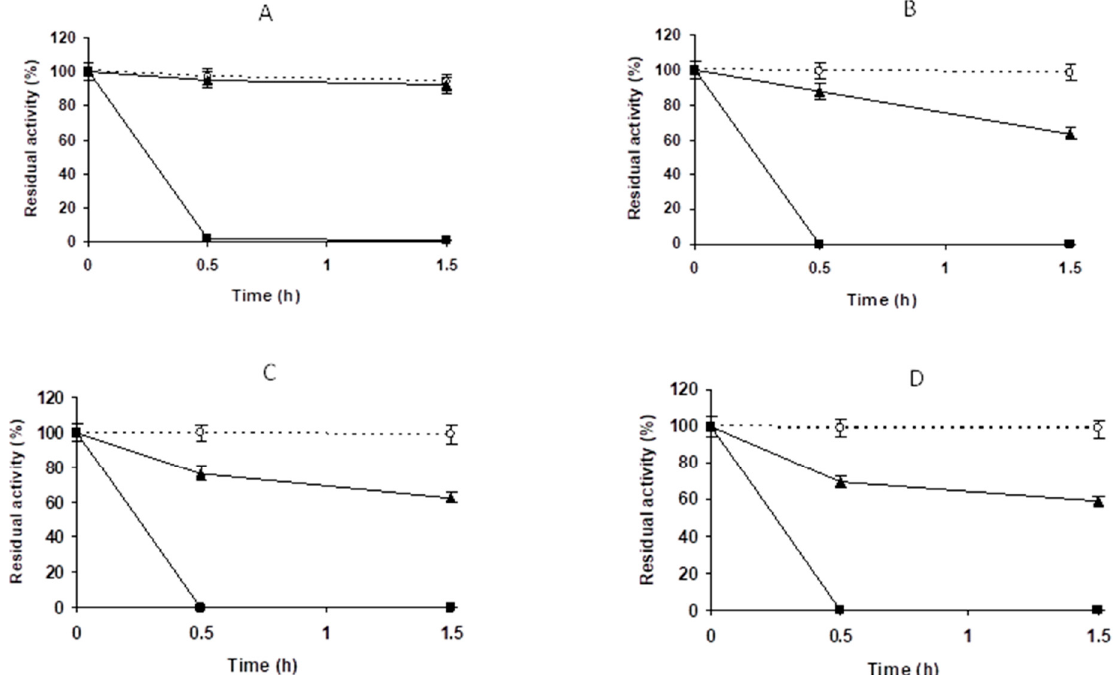
Figure 7. Immobilization courses of PGA (2.5 mg/g) on glyoxyl agarose ( A ) and on vinyl sulfone in 1 M sodium sulfate at 25 °C at different pH values. ( B ) pH at 7.0; ( C ) pH at 8.0; ( D ) pH at 9.0. Empty circles with dashed line: reference suspension. Full triangles with solid line: suspension. Full squares with solid line: supernatant. Other specifications are described in Methods.